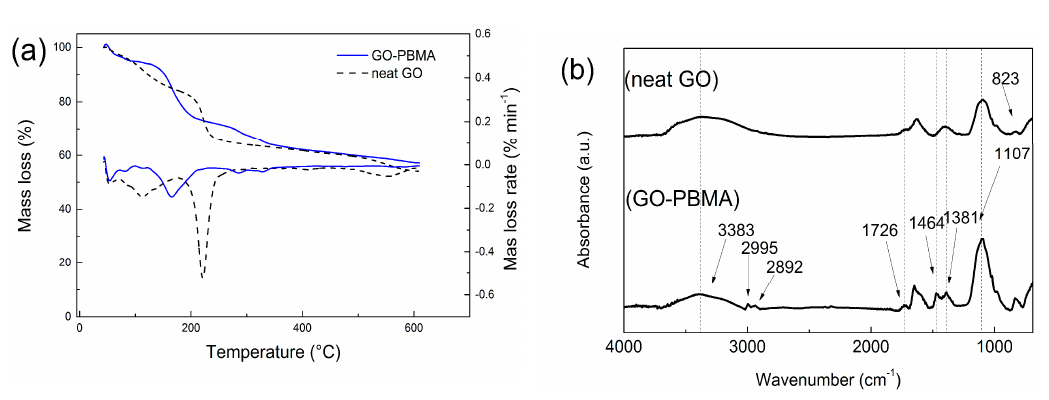
Figure 2. TGA spectra ( a ) and FTIR spectra ( b ).